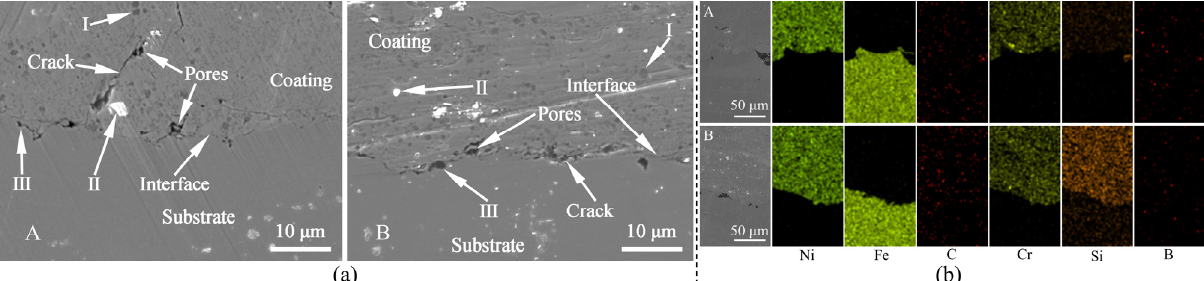
Figure 8. SEM images and EDS analysis results of the cross-section of specimen A and specimen B. SEM images ( a ) and the chemical elements distribution maps ( b ) of the cross-section of specimen A and specimen B. Table 6. The chemical elements of point I, point II and point III in Figure 8a (wt.%). Point I Point II Element Coating